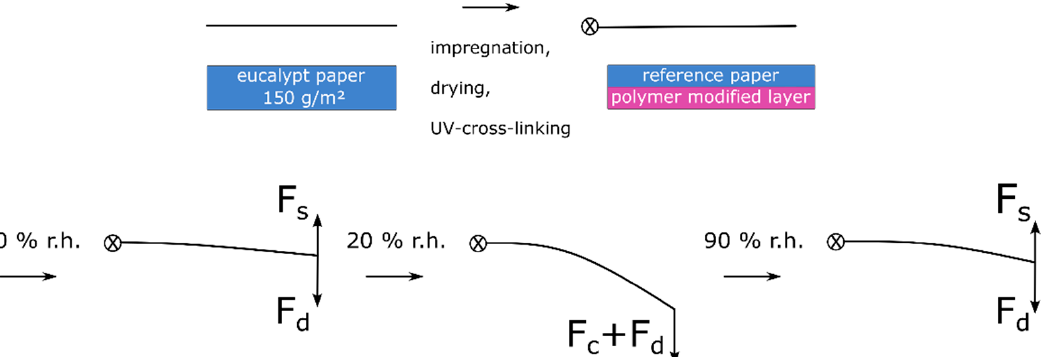
Figure 12. Schematic representation of the forces acting upon the single-layer paper actuator during copolymer impregnation, drying, pressing and upon exposing it to different relative humidity regimes. The forces represent the drying-induced residual stresses (F d ) after impregnation and the forces resulting from dissimilar hygroexpansion of the unmodified resistance “layer” and the copolymer-modified active “layer” of paper due to the swelling (F s ) and compaction (F c ) of the active